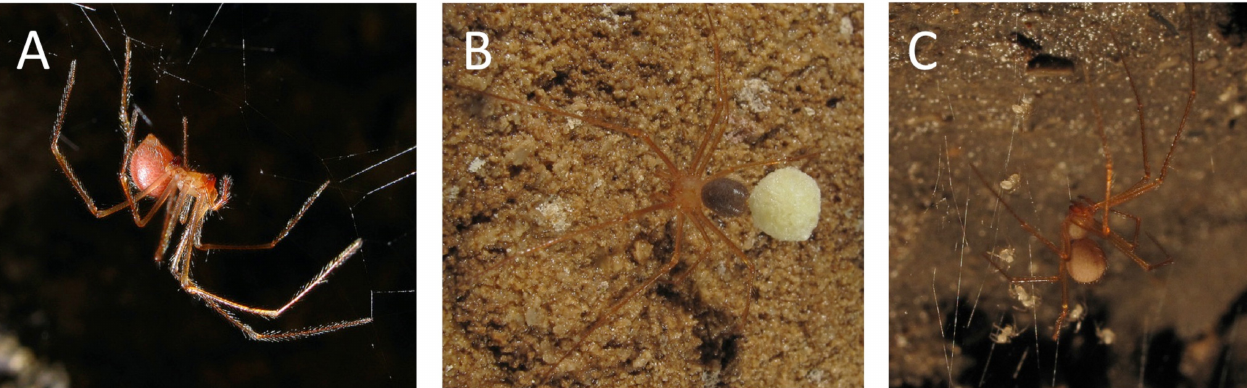
Fig 1. Photos of troglobiotic Nesticus . (A) N . barri female in web (The Marlow Holes, Franklin County, Tennessee); (B) N . stygius with egg sac (Obe Lee Cave, Overton County, Tennessee); and (C) N . furtivus with spiderlings (Raccoon Mountain Caverns, Hamilton County, Tennessee). All photos by Alan